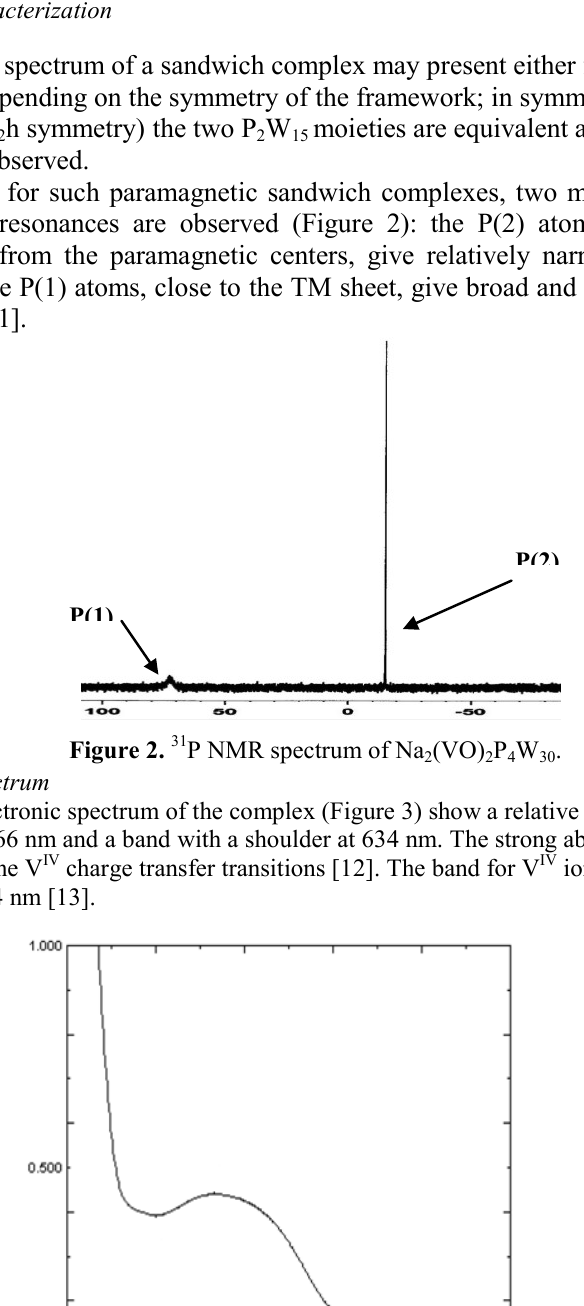
(VO) P W 2 2 4 30